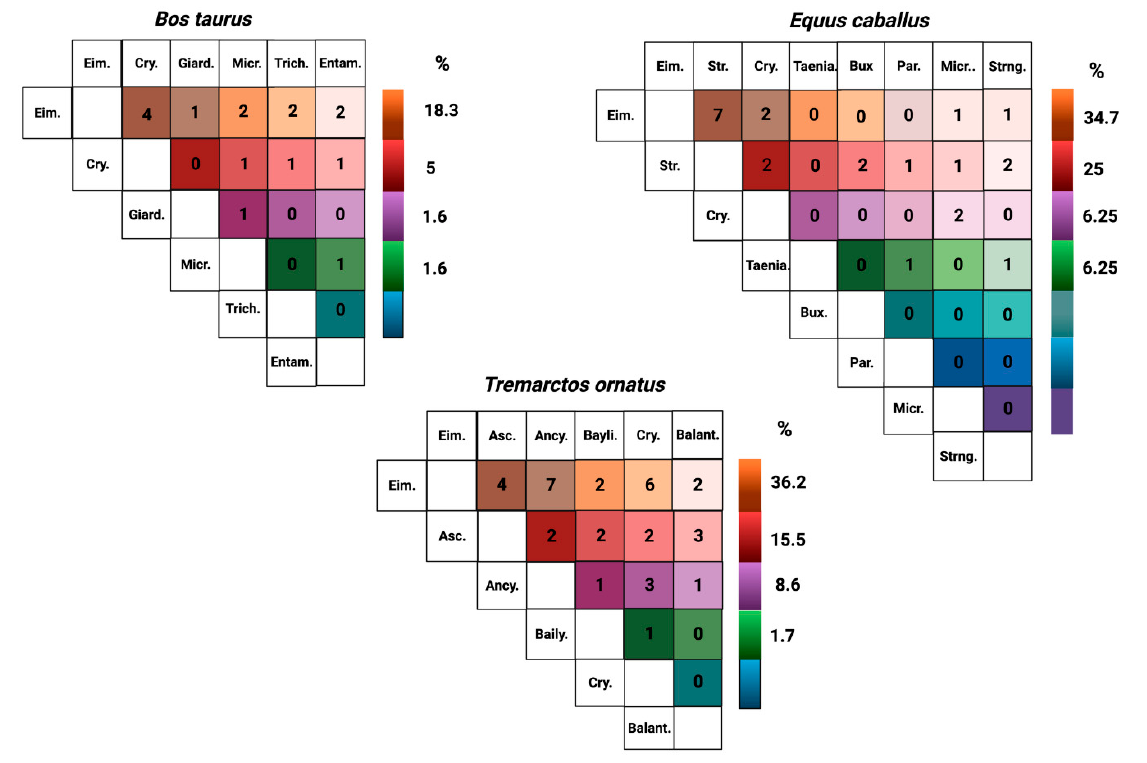
Figure 3. Quantity of individuals for each possible combination of endoparasites. Eim: Eimeria, Cry: Cryptosporidium spp., Giard: Giardia spp., Micro: Microsporidium spp., Trich: Trichostrongylus spp., Entam: Entamoeba spp., Str. Strongylus spp; Taenia: Taenia spp., Bux: Buxtonella sulcata , Par: Parascaris equorum , Std: Strongyloides spp., Asc: Ascaris lumbricoides , Ancy: Ancylostoma spp., Bayli: Bailisascaris venezuelensis , Balant: B. coli .